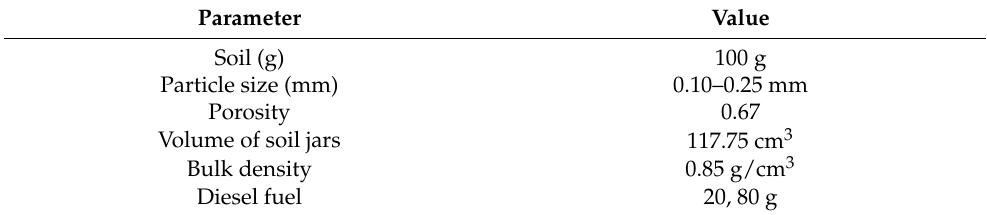
Table 1. The properties of soil samples.